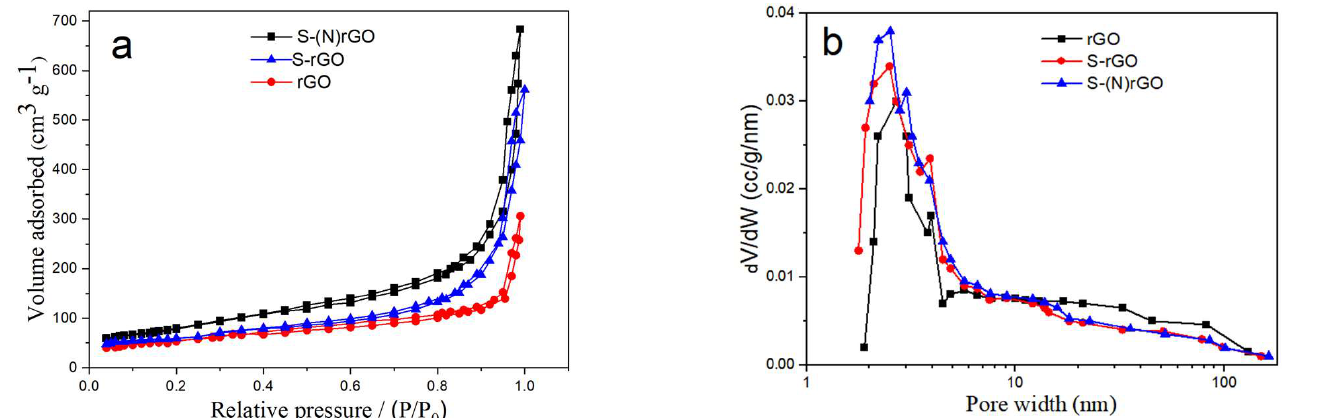
Figure 5. ( a ) N 2 adsorption/desorption isotherms of the supporting materials at 77 K; ( b ) Pore size distribution of the supporting materials calculated by the Barrett − Joyner − Halenda formula from the desorption branch of N 2 adsorption.